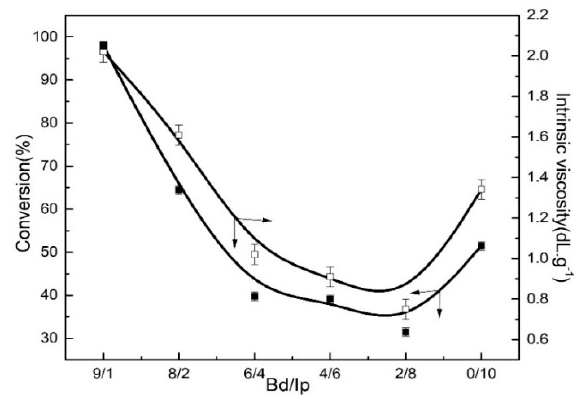
Figure 7. Effect of Bd:Ip mole ratios from 9:1 to 0:10 on the monomer conversion and intrinsic viscosity at a Bd:Ip mole ratio of 9:1. Polymerization conditions: [M] = 0.18 g ∙ mL − 1 , TNPP:Mo = 6, Al:Mo = 5, T = 60 °C, Mo:[M] = 8 × 10 − 4 , t = 7 h.